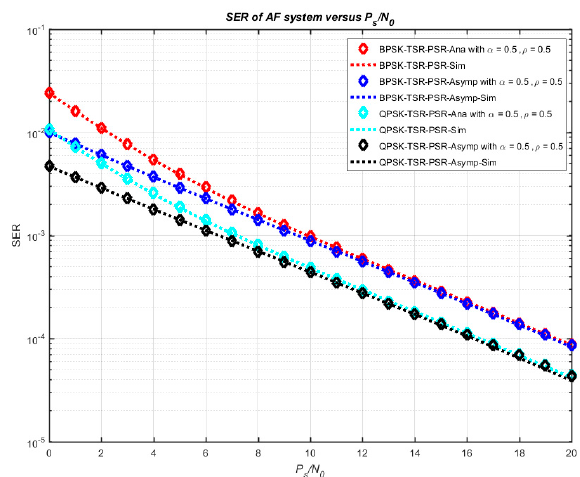
Figure 8. SER versus P s / N 0 in the cases TSR, PSR, and TSR–PSR.